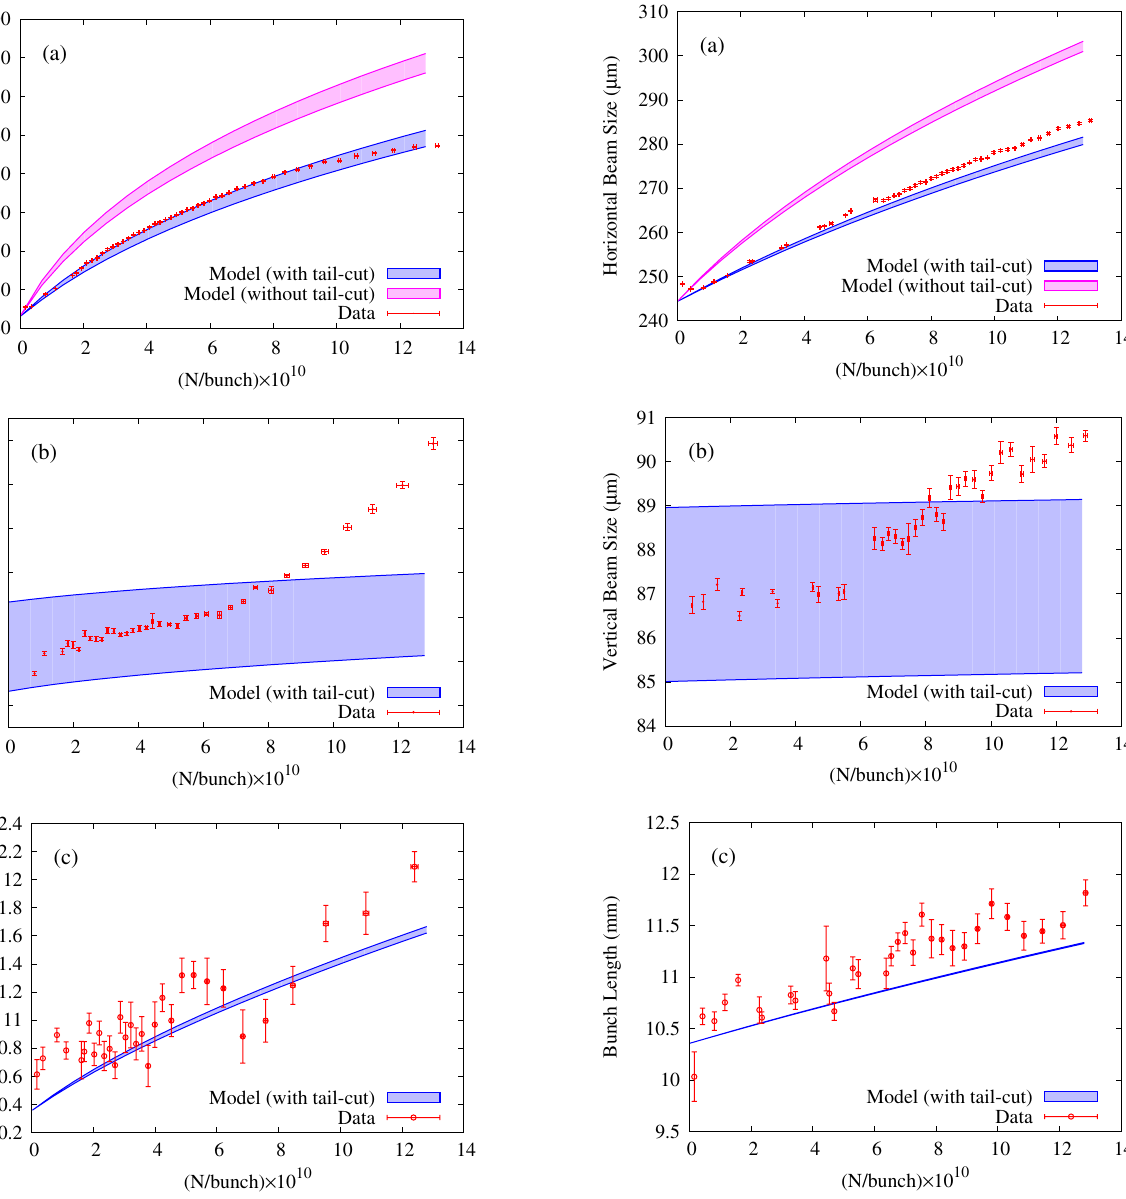
FIG. 12. (a) Horizontal, (b) vertical, and (c) longitudinal beam size versus current for e (cid:1) bunch in conditions tuned for mini- mum vertical emittance.